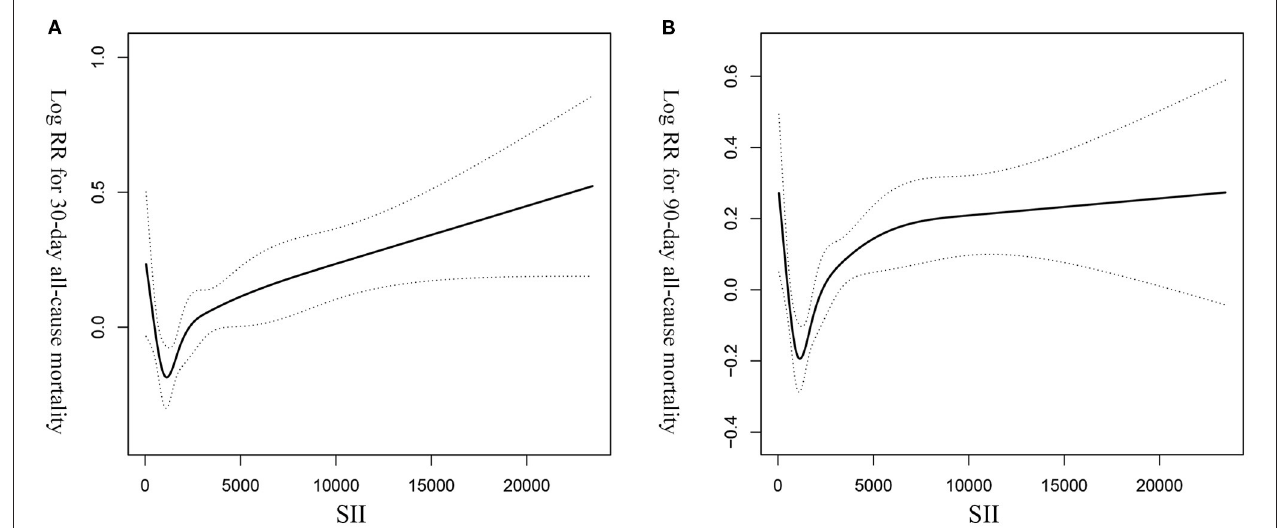
FIGURE 2 | The non-linear curve fitting of the association between SII and 30- (A) and 90- (B) day all-cause mortalities in critically ill patients with CHF after adjusting for age, gender, race, and other potential variables. SII, systemic immune-inflammation index. CHF, congestive heart failure.